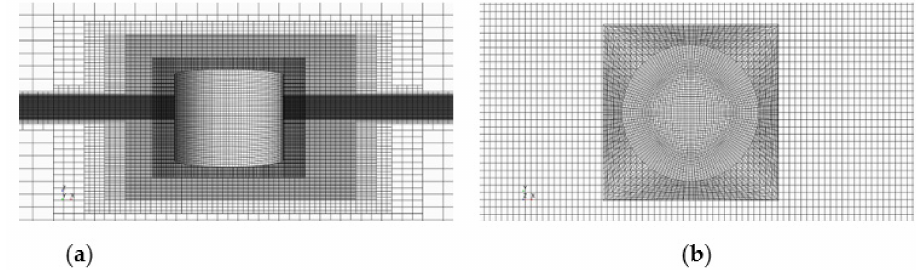
Figure 6. Grid refinement at free surface and region surrounding the buoy: ( a ) side view; ( b ) top